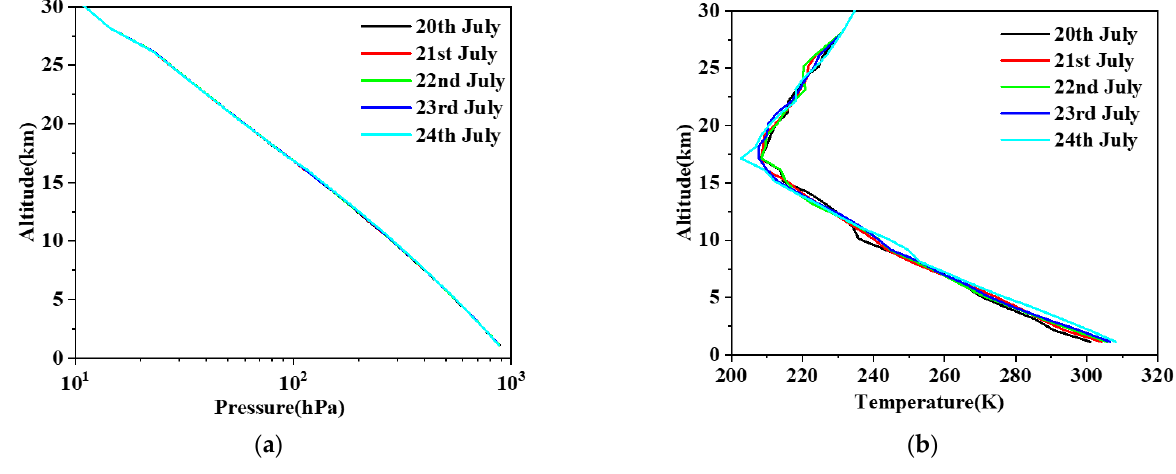
Figure 6. The pressure and temperature profiles at Dunhuang. ( a ) The measured atmospheric pressure profile during the experiments; ( b ) The measured atmospheric temperature profile during the experiments.